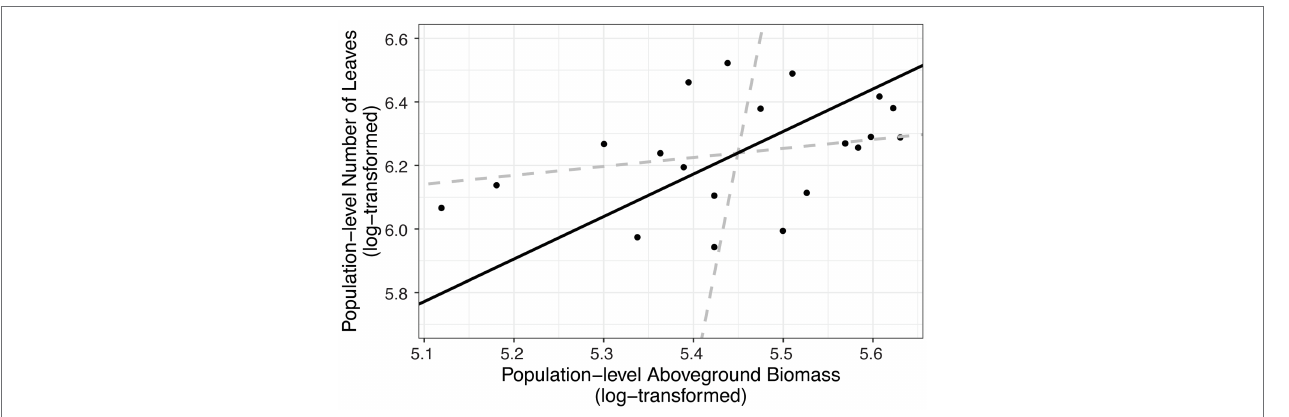
FIGURE 4 | Number of leaves in a population was correlated with dry aboveground biomass of a population. We summed the total number of leaves and the biomass (in grams) of each population (the level at which other analyses were performed). Each point represents a host population in the 2017 experiment. The black solid line indicates ranged major axis fit, and the gray dashed lines indicate 95% CIs. The total number of leaves (log-transformed) at the end of the experiment was correlated with log-transformed dry aboveground biomass ( R 2 = 0.145, permutation test, p = 0.045).